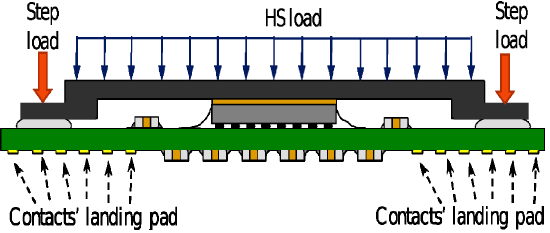
Figure 4. Load on integrated beat spreader.